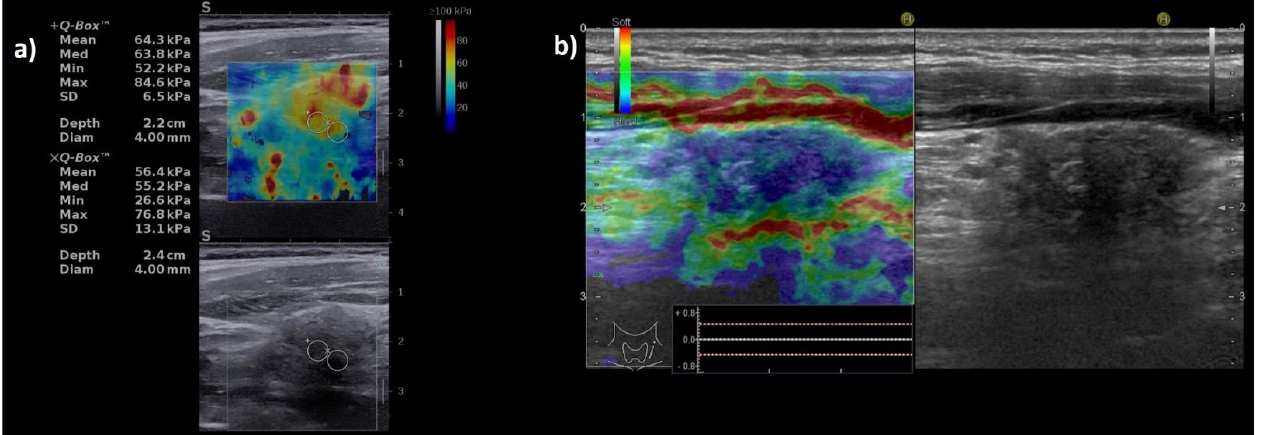
Figure 10. Illustration of false-positive elastography results in a case with Riedel thyroiditis. Appearance of hypoechoic thyroid nodule, with increased stiffness both in ( a ) shear-wave elastography: Mean elasticity index = 64.3 kPa; and in ( b ) strain elastography: entirely stiff nodule (entirely blue), Asteria score of 4 and strain ratio = 5.5.